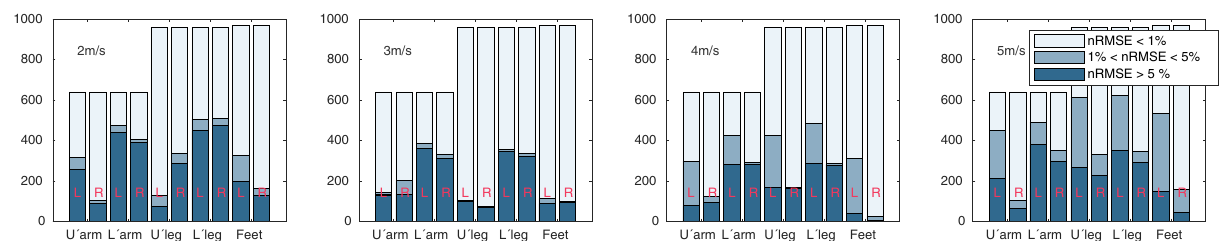
Figure 5. Overview on sensor position dependent stride duration estimation errors in the athlete study, including all simulated sensors at left (L) and right (R) body sides and all running speeds. The total study statistics include 640 simulated sensors at upper and lower arms, 960 sensors at upper and lower legs, and 970 sensors at each foot.